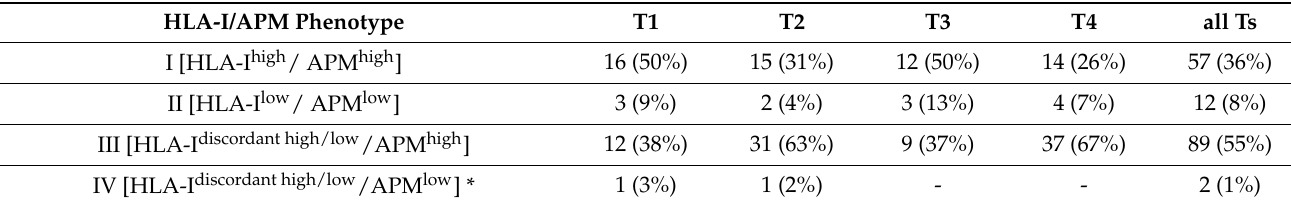
Table 4. Distribution of T Stages Across HLA-I/APM Phenotypes.